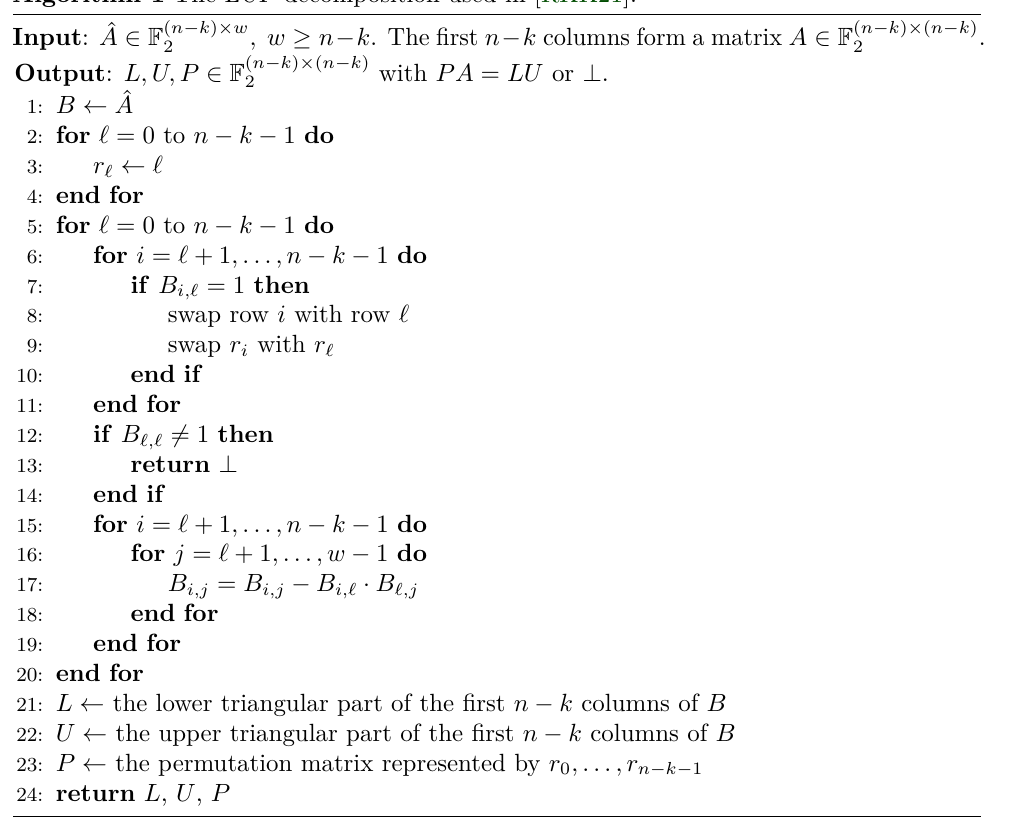
Algorithm 1 The LUP decomposition used in